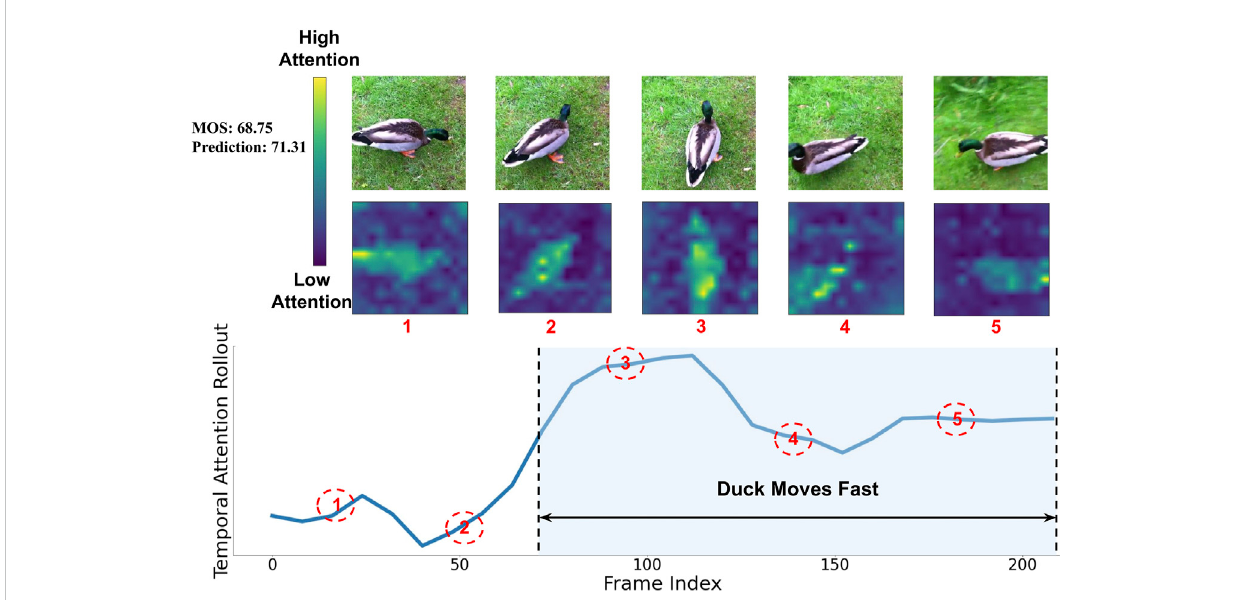
FIGURE 6 Visualization of spatial and temporal attention from output tokens to the input. The heat-map on the top shows the spatial attention. The chart on the bottom shows the temporal attention. Higher attention values correspond to the more important video segments and spatial regions for prediction. The model is focusing on spatially and temporally more meaningful content when predicting the fi nal video quality